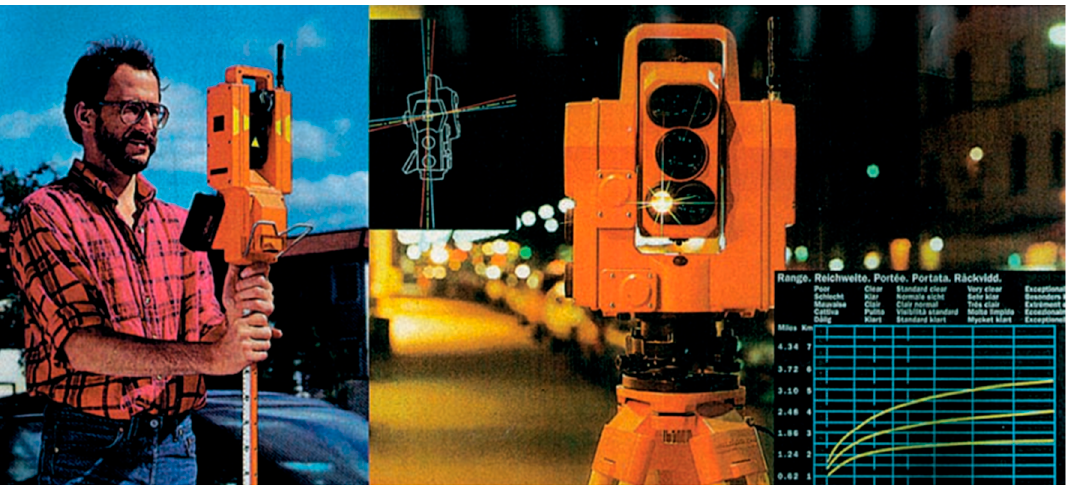
Figure 7. Geodimeter model 4000, i.e., the first “One-Man-System” in the world that required only one expert to operate it [22].